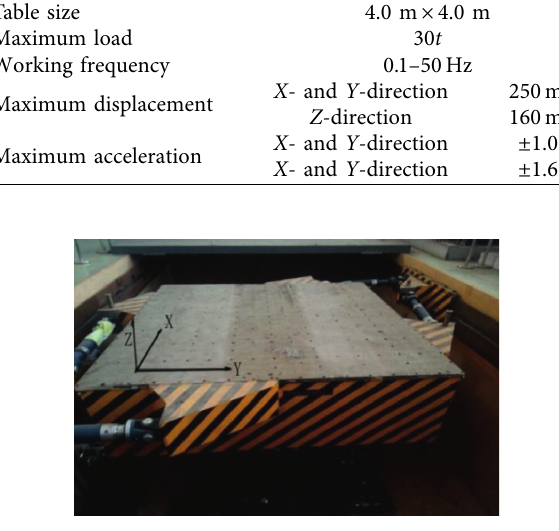
Figure 1: Shaking table. Table 2: The main similarity constants of the model to